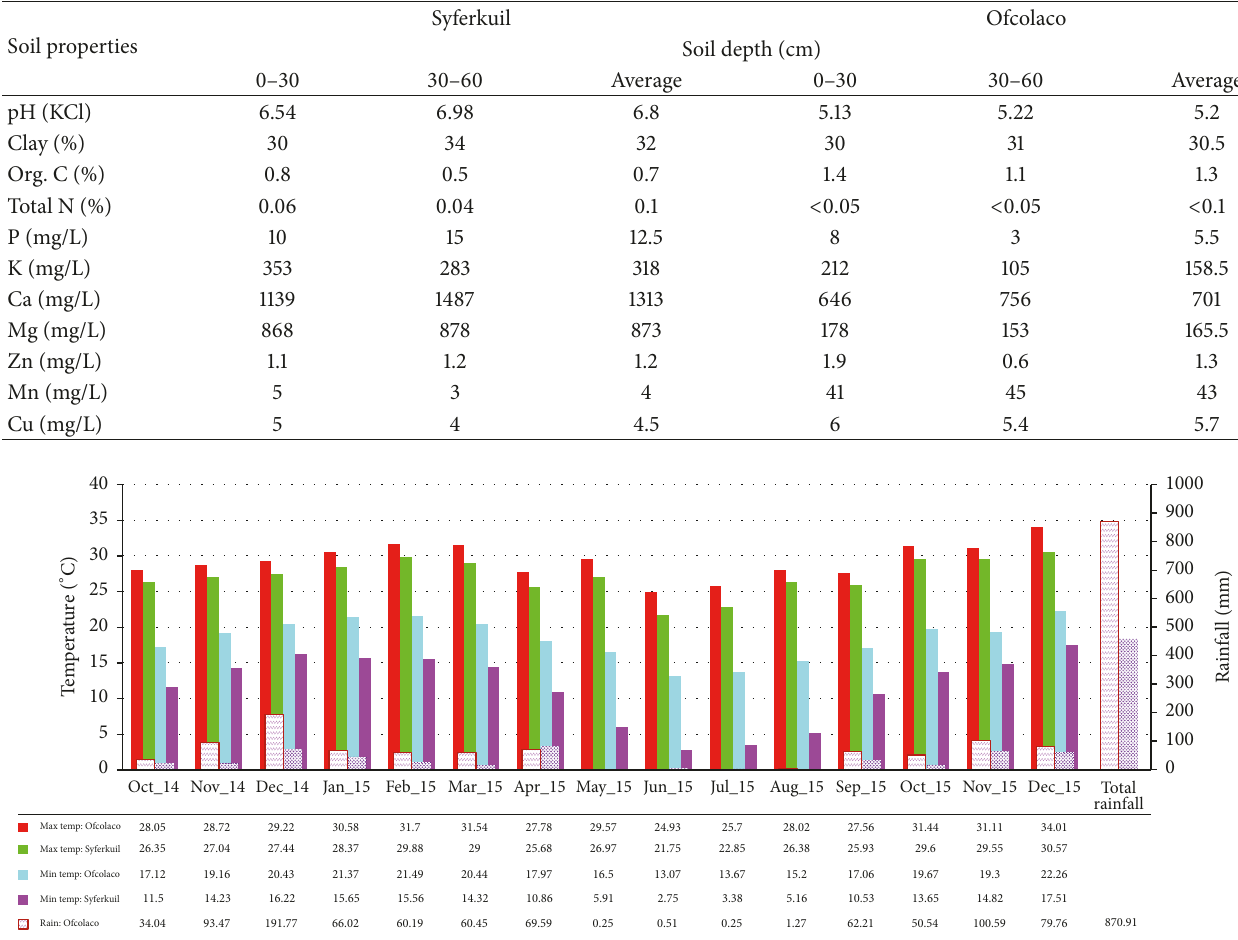
Table 1: Physical and chemical properties of soil at the experimental sites.